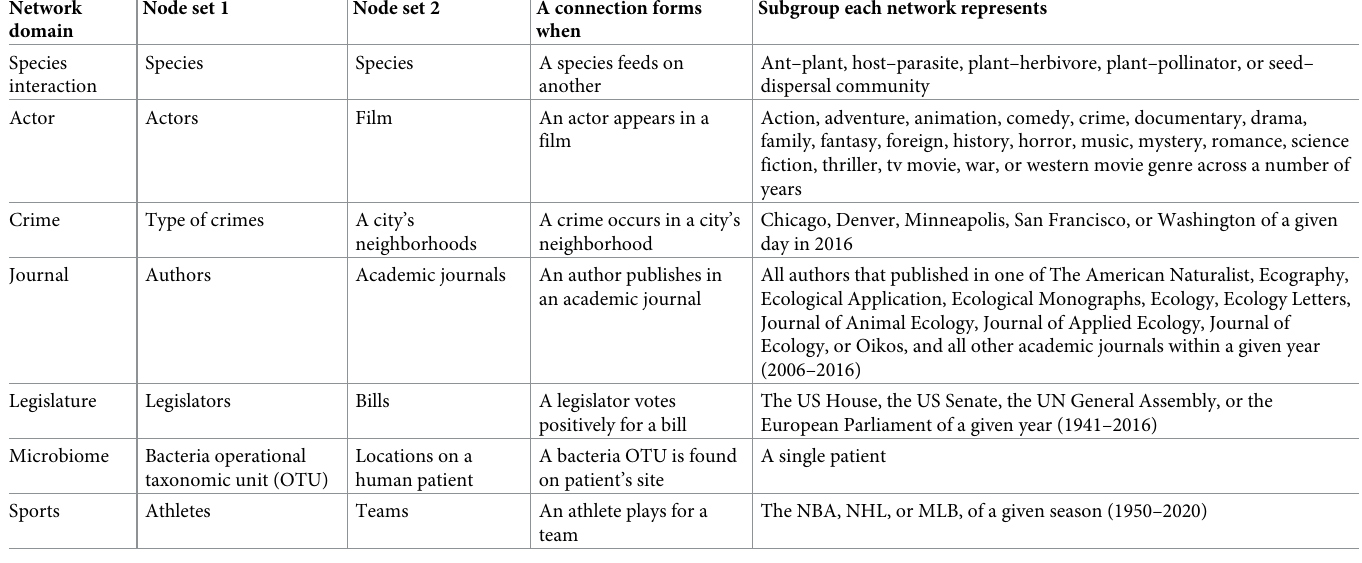
Table 2. Description of bipartite networks used in this